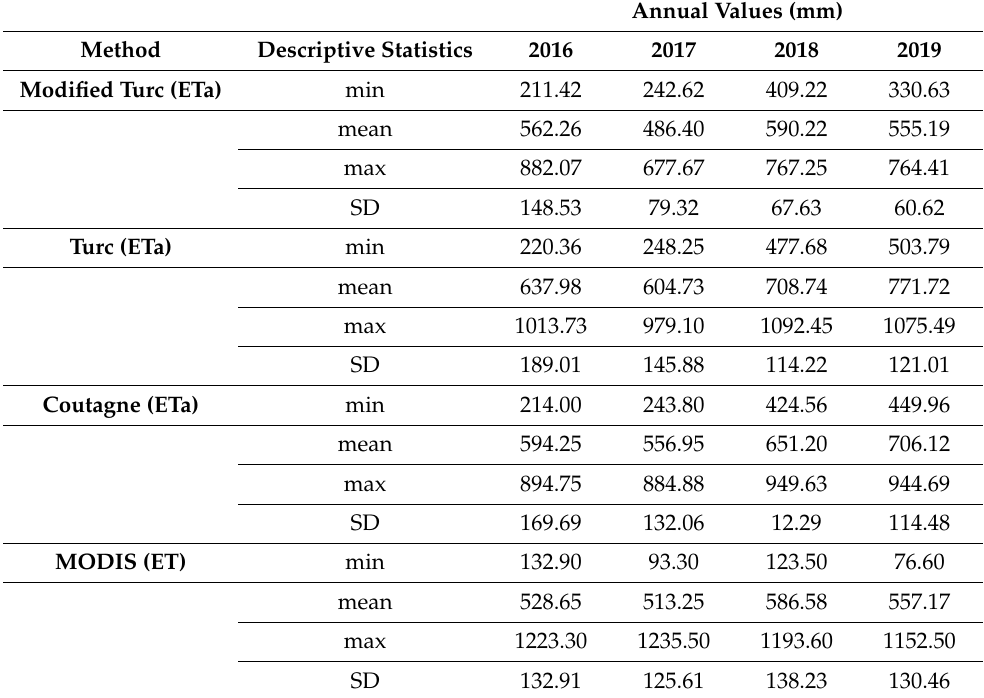
Table 2. Descriptive statistics of annual ETa from empirical methods and MODIS ET estimates for